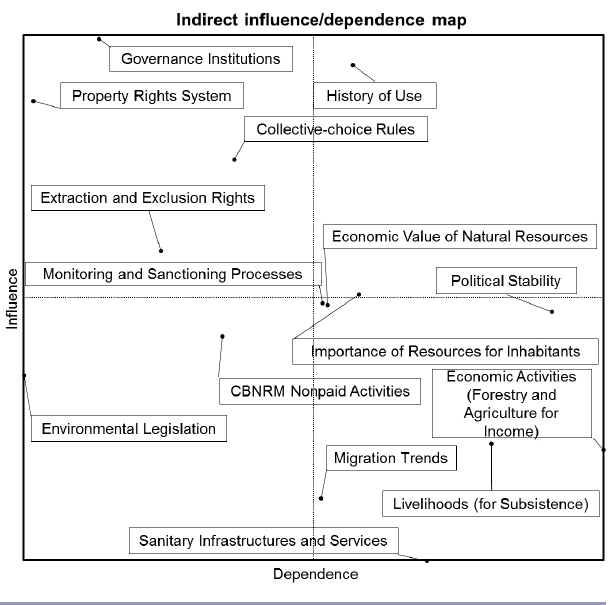
Fig. 9 . Influence/dependence map for indirect influences in Mexico.